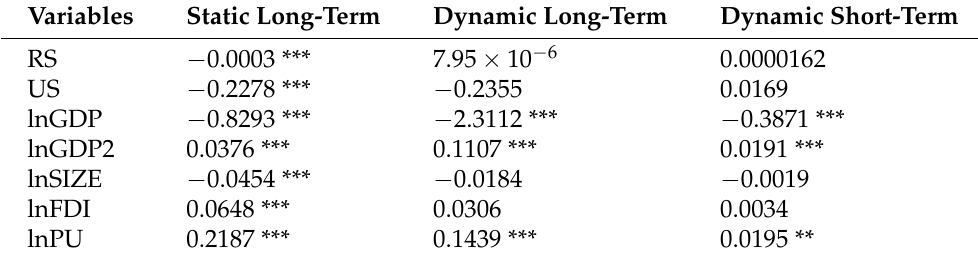
Table 8. Spatial direct